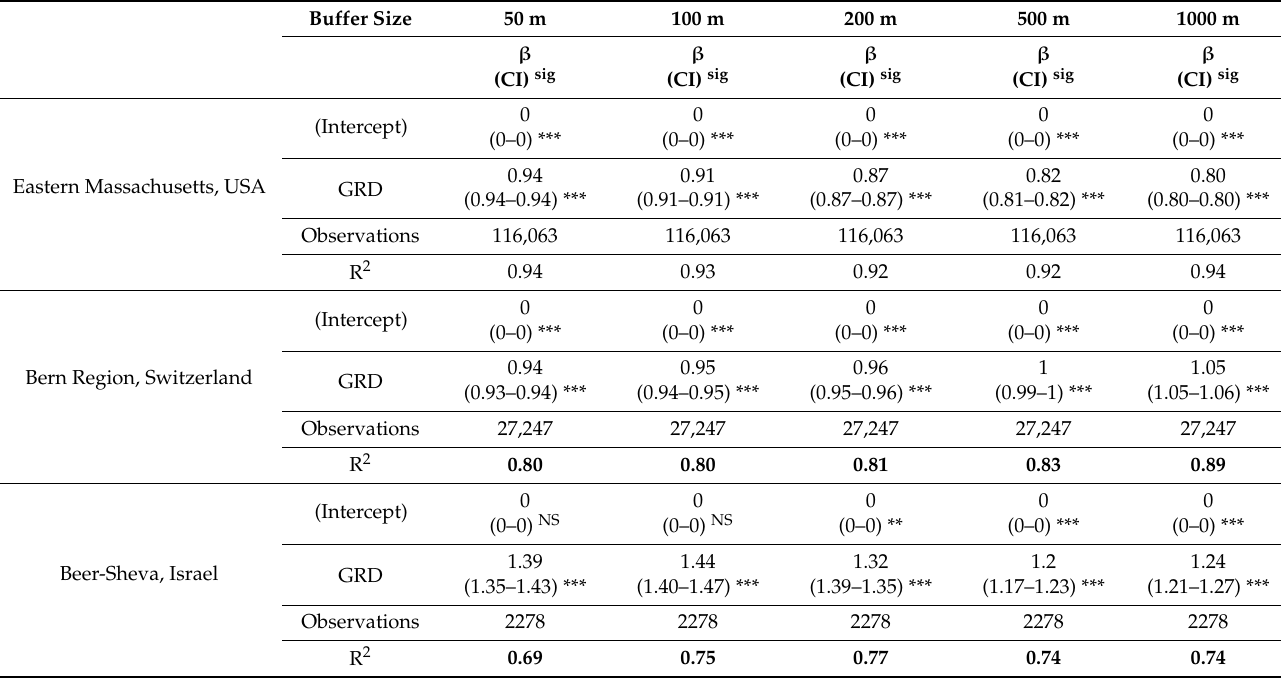
Table 6. Road density exposure assessment linear model results. β = Beta, CI = Confidence interval, ** p < 0.01; *** p < 0.001; NS = not